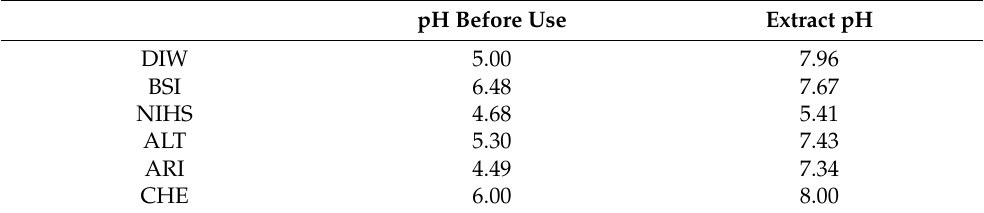
Table 5. Comparison between pH of freshly prepared sweat solutions and pH of soil